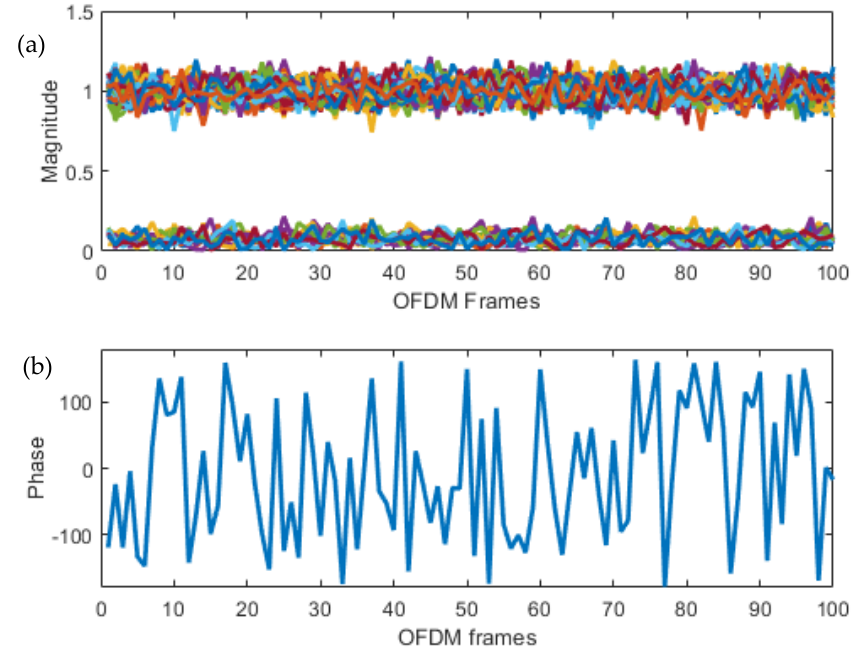
Figure 6. AWGN channel response ( a ) magnitude; ( b ) phase.